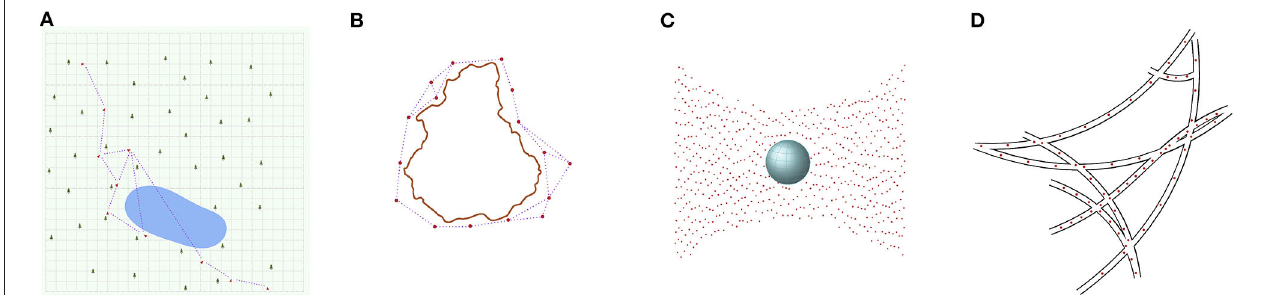
FIGURE 1 | Application scenarios involving sparse swarms. A swarm of ten rovers (red markers) is tasked to monitor a 25 km 2 forest ground. The rovers travel from South West to North East through the forest (depicted by tree symbols and green background), and the rovers that encountered the lake (depicted in blue) need to find a detour around it, leading to a concentration of rovers westwards of the lake (A) . A swarm of 16 surface vehicles is tasked to monitor the costal waters at the perimeter of an island of size 30 × 35 km 2 (outlined in brown), which involves station-keeping around the island (B) . In both (A,B) , the communication links (indicated by dotted lines) are intermittent for the moving robots, due to signal attenuation by features of the environment. Free line-of-sight across the lake (in A ) enhances the communication range. A swarm of 445 satellites self-organize into a 3-D spatial pattern providing continuous coverage for high-resolution imaging (C) . A swarm of around 100 microrobots search for blockages in a vascular network, using stigmergic interactions for coordination (D) .